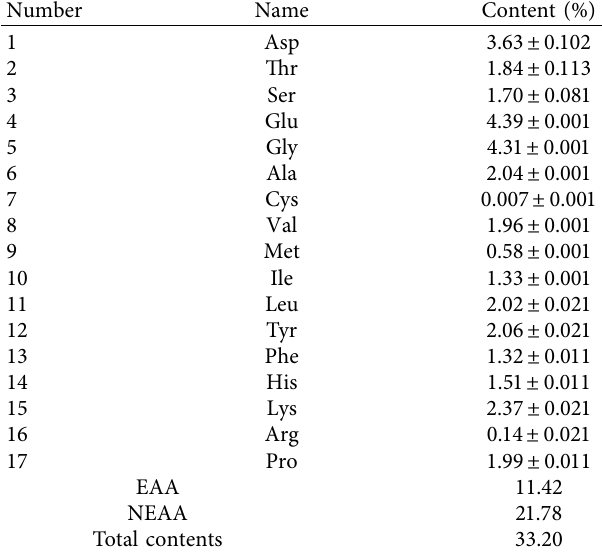
Table 2: Composition and content of hydrolyzed amino acids in C. militaris